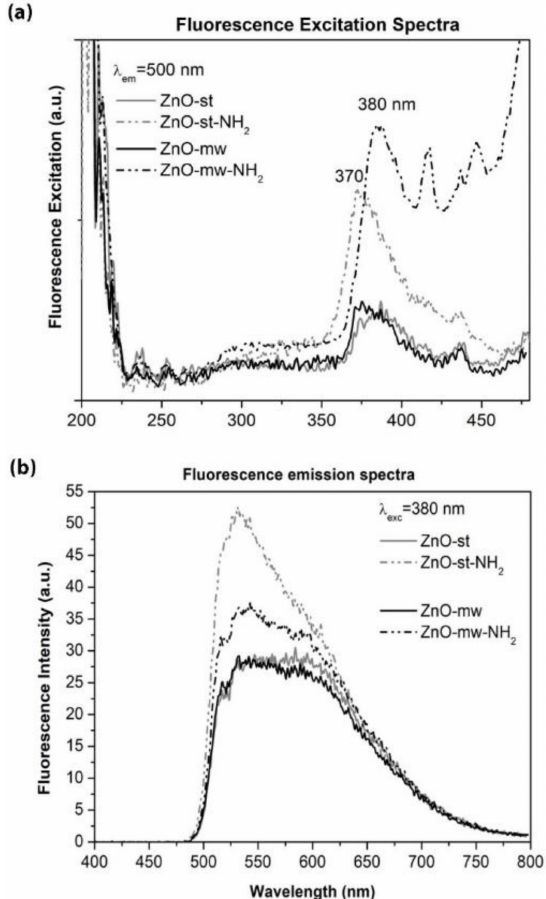
Figure 8. Luminescence properties of the pristine (solid line) and functionalized (dashed line) ZnO NCs obtained with the two preparation methods (conventional, in grey vs. microwave, in black). ( a ) Excitation spectra (recorded at the emission wavelength of 550 nm), ( b ) emission spectra (acquired at the excitation wavelength of 380